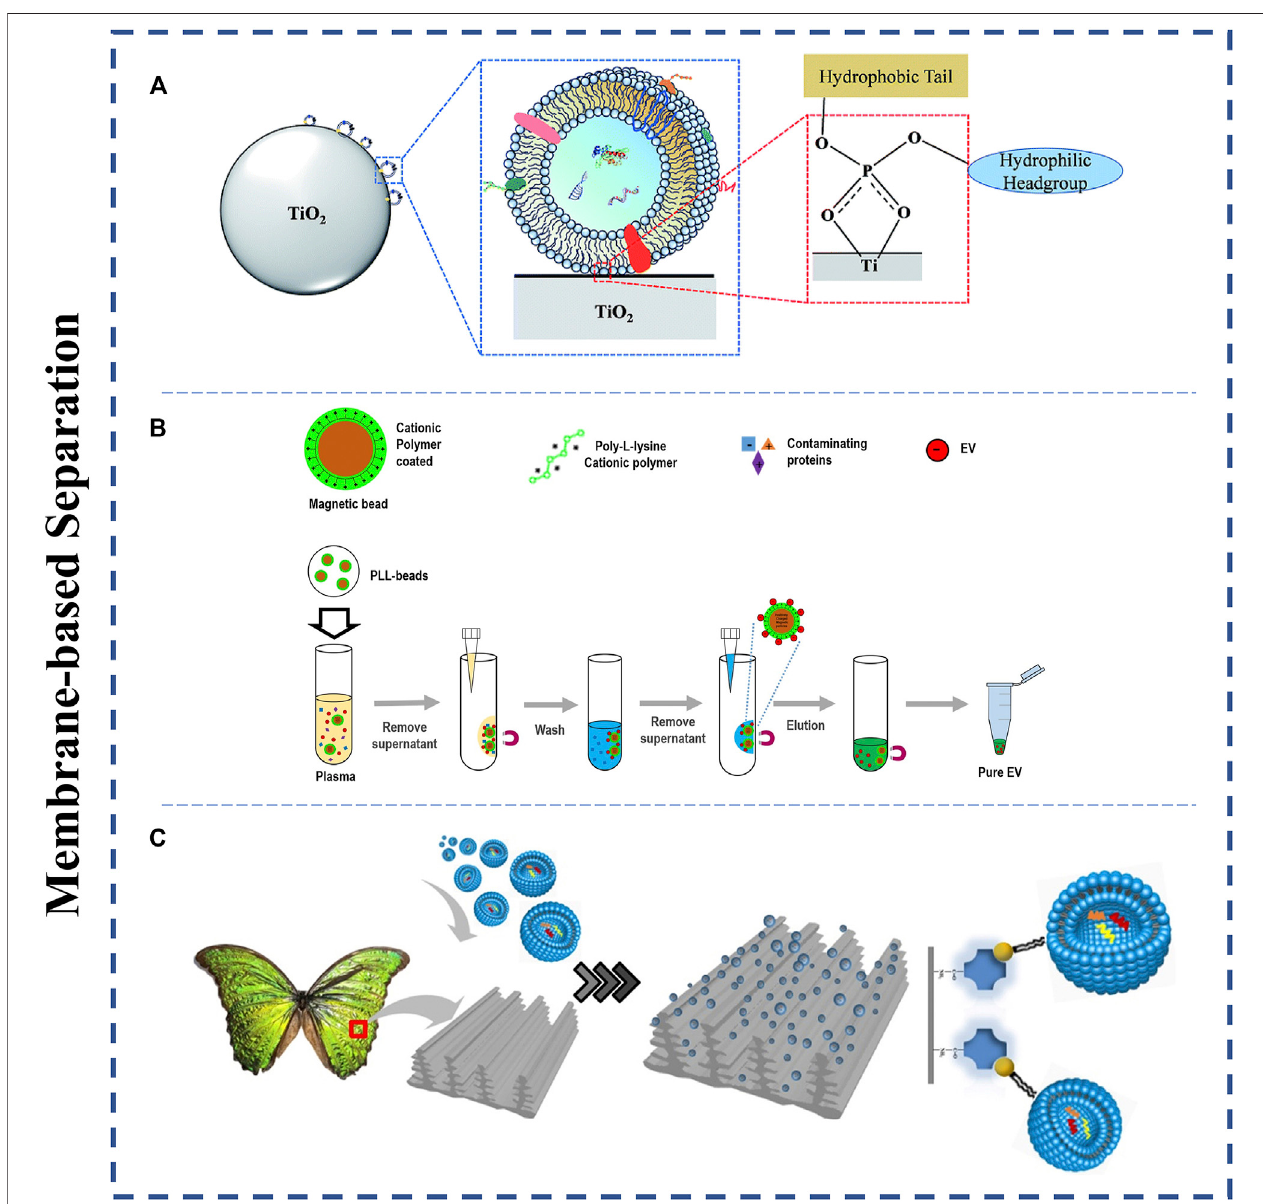
FIGURE 5 | Schematic representation of Membrane-based exosome isolation techniques. (A) The phosphate groups on the membrane surface of exosomes can speci fi cally bind to metal oxides (TiO 2 ). Adapted from (Gao et al., 2019), copyright 2019 Royal Society of Chemistry. (B) The positively charged molecules enrich exosomes. Adapted from (Kim and Shin, 2021), copyright 2021 MDPI. (C) The lipid nanoprobes with lipid tail are capable of inserting into the exosomal membrane structure. The wings modi fi ed with lipid nanoprobes can promote the ef fi ciency and speed of exosome binding to nanoprobes. Adapted from (Han et al.,